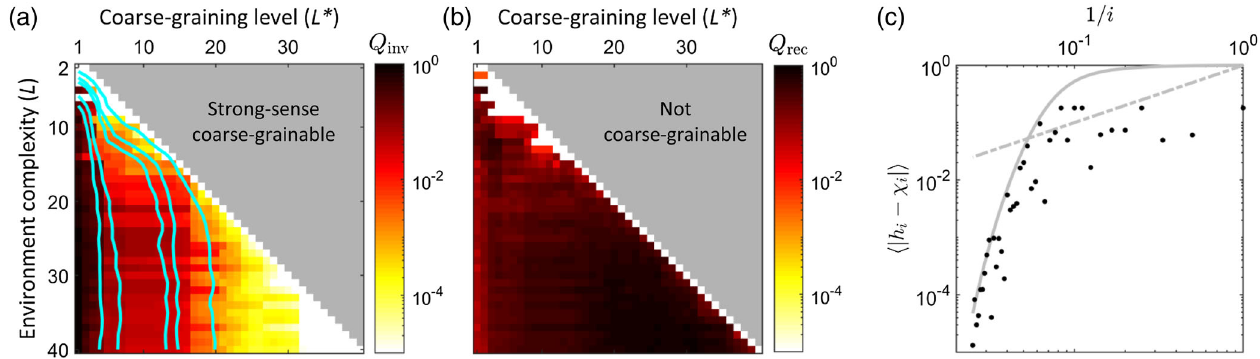
FIG. 5. The same ecosystem can be coarse-grainable under one criterion, but not under another. (a) If coarse-graining quality is evaluated using the leave-one-out test (assessing reproducibility of strain invasion rates), our ecosystem model is coarse-grainable in the strong sense: The acceptable level of coarse-graining, determined by the desired quality score (isolines of Q ), is robust to environment complexity [compare to Fig. 3(f)]. (b) In contrast, under the reconstitution test criterion, no amount of coarse-graining is acceptable [compare to Fig. 3(d)]. This comparison shows that a coarse-graining can be operationally valid for a given purpose (a) even when the strains it groups together are functionally diverse (b). Both heat maps represent a single random biochemistry, the same in both. Isolines in (a) are averaged over 20 biochemistries to demonstrate robustness (see Supplemental Material [31]). (c) Explaining the origin of strong-sense coarse-grainability in our model. The plot shows the scaling with i of j h i − χ i j [computed for L (cid:3) ¼ 30 , L ¼ 40 , and averaged across communities assembled for the leave-one-out test in (a)]. The strong-sense coarse-grainability in (a) is ensured whenever the decay is faster than 1 =i (dashed gray line). Intuitively, this makes the tail-end traits approximately neutral in the assembled community; see the text. We expect this scaling to be controlled by the sigmoidal decay of trait interaction magnitude j J ij j , as confirmed here [solid gray line; the same as Fig. 2(b) but normalized to a maximum of 1 to show the decay of interaction strength rather than their absolute